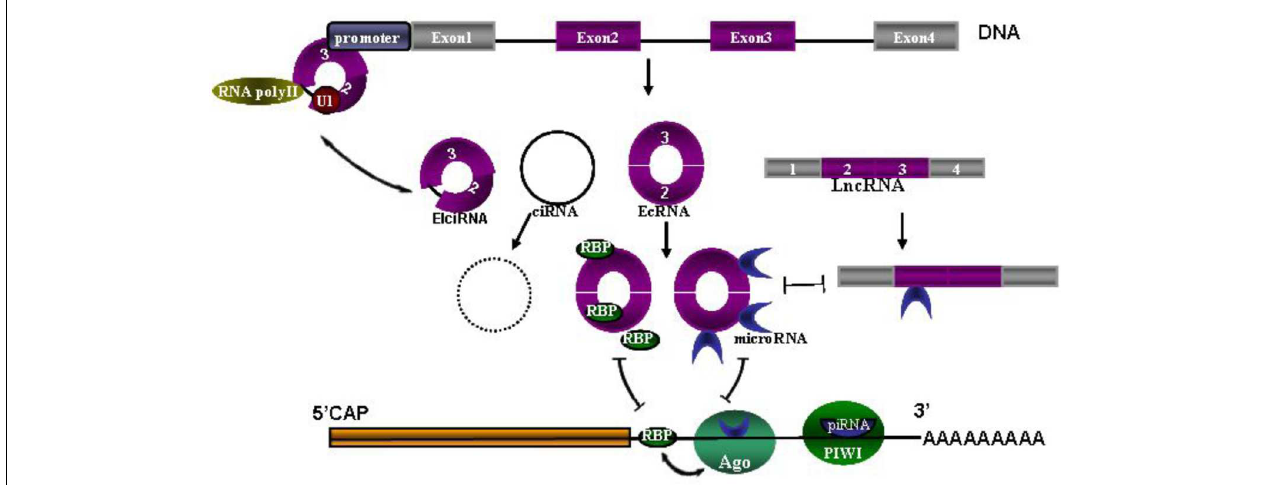
FIGURE 1 | The network of circRNAs, microRNAs, piRNA and lncRNAs. Coding sequence (CDS) and 3 (cid:48) untranslated region (UTR) are followed by polyA tail. MicroRNAs are bound with Argonaute (Ago) proteins and also bound to partially complementary sites in the 3 (cid:48) UTR. Similarly, piRNAs loaded in PIWI associate with the 3 (cid:48) UTR by full complementarity binding. Ago-miRNA activity is further modulated by adjacent RNA-binding proteins (RBPs), presumably by interacting with target proteins. Three types of circRNAs are spliced from DNA, including exon-shuffling-derived circRNA (ecRNA), which is only comprised of exons; circular intronic RNA (ciRNA), which is the byproduct formed by intron after pos-transcription; and elciRNAs (exon–intron RNAs), which is consisted of exon and retained intron, and long intron with reverse complementary sequences flanking the joined exons. CiRNAs and elciRNAs can interact with transcription machinery (RNA Pol II and U1 snRNP) to promote their parent gene expression in the nuclei. Long non-coding RNA (LncRNA) could also act as competitive endogenous RNAs to compete for microRNA binding.